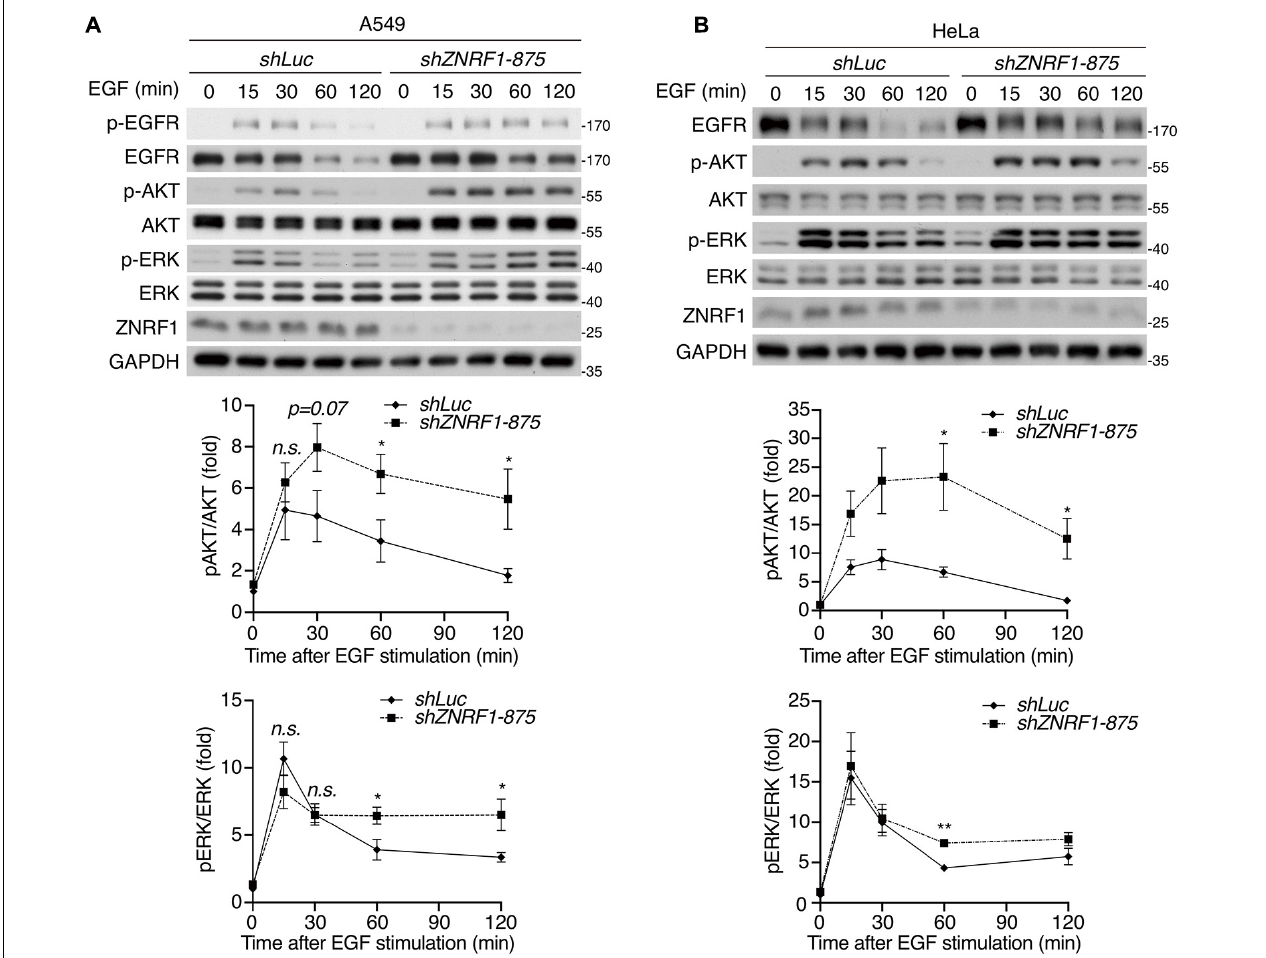
FIGURE 2 | ZNRF1 modulates EGFR signaling. A549 (A) and HeLa (B) cells infected with lentivirus expressing shRNA against luciferase ( shLuc ) or ZNRF1 ( shZNRF1 ) were serum-starved overnight, and then stimulated with 100 ng/mL EGF for the indicated times. Cell lysates were prepared, and the levels of EGFR, ZNRF1, activation of EGFR, AKT, and ERK were analyzed by immunoblotting. Quantification of immunoblotting analysis data of three independent experiments are shown in the lower panels. Results are presented as averages ± SEM. n.s., no significant; * P < 0.05, ** P < 0.01 (Student’s t